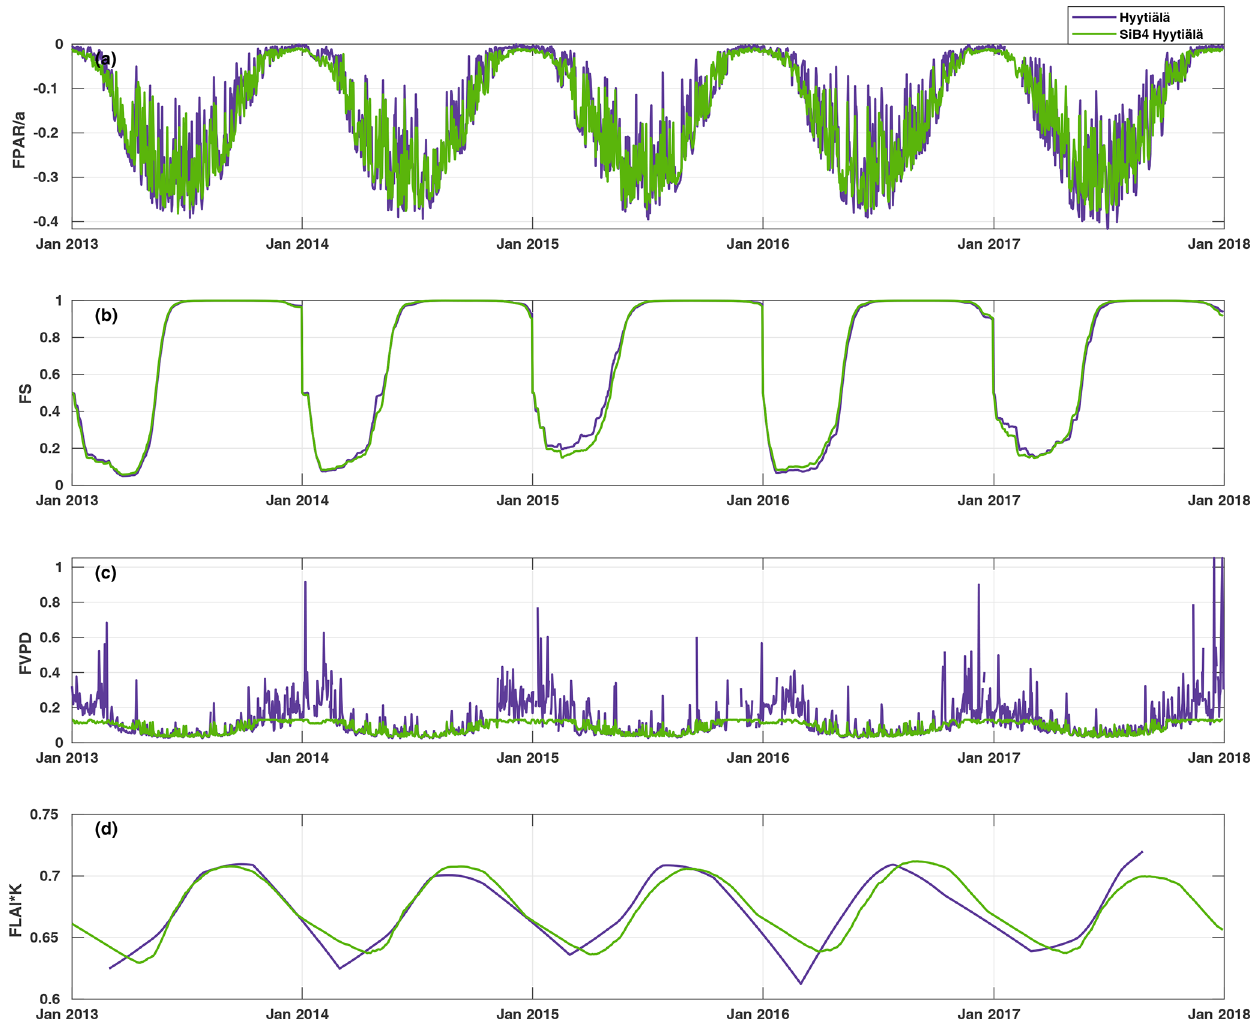
Figure 4. Time series of the daily average values of the parameter functions (Eqs. 2–5) normalized to vary between zero and one. The purple line represents the parameterization, and the green line represents the parameterization with SiB4 in Hyytiälä. The abbreviations used in the figure are as follows: FPAR – stomatal response to PAR, FS – phenology of biochemical reactions, FVPD – stomatal regulation, and FLAI – foliage and canopy light